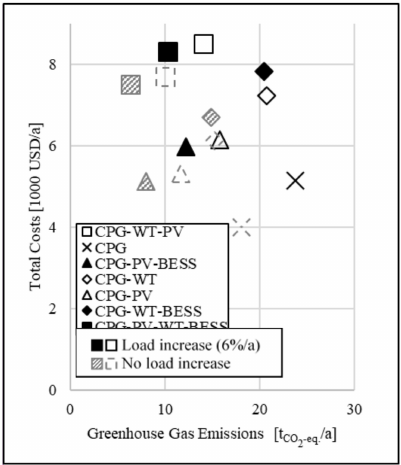
Figure 5. Economic and ecological outcomes of the renewable energy systems based on the NESSI4D